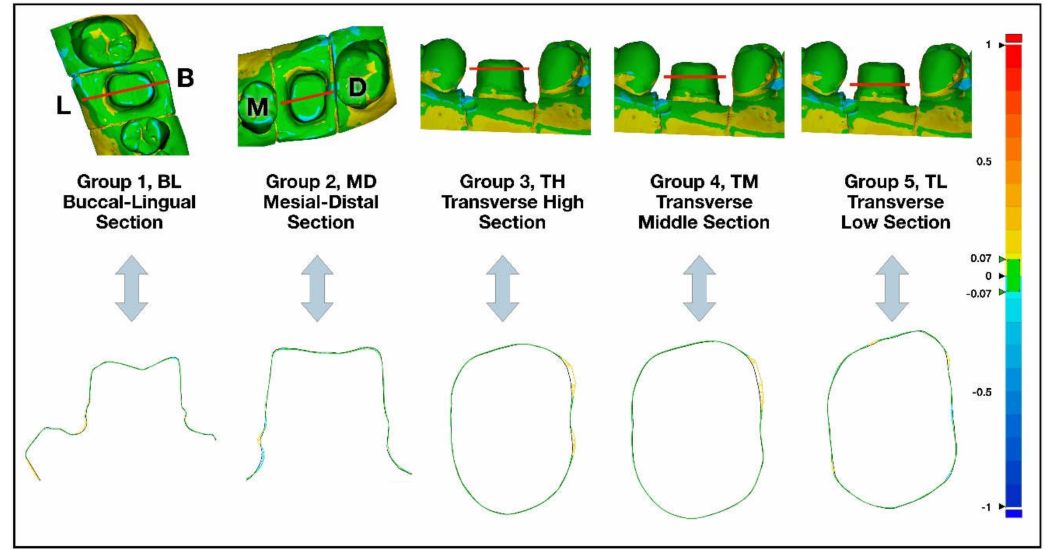
Figure 1. Superimposed 3D data images were sectioned to five following 2D planes: buccal-lingual section (BL, group 1), mesial-distal section (MD, group 2), transverse high section (TH, group 3), transverse middle section (TM, group 4), and transverse low section (TL, group